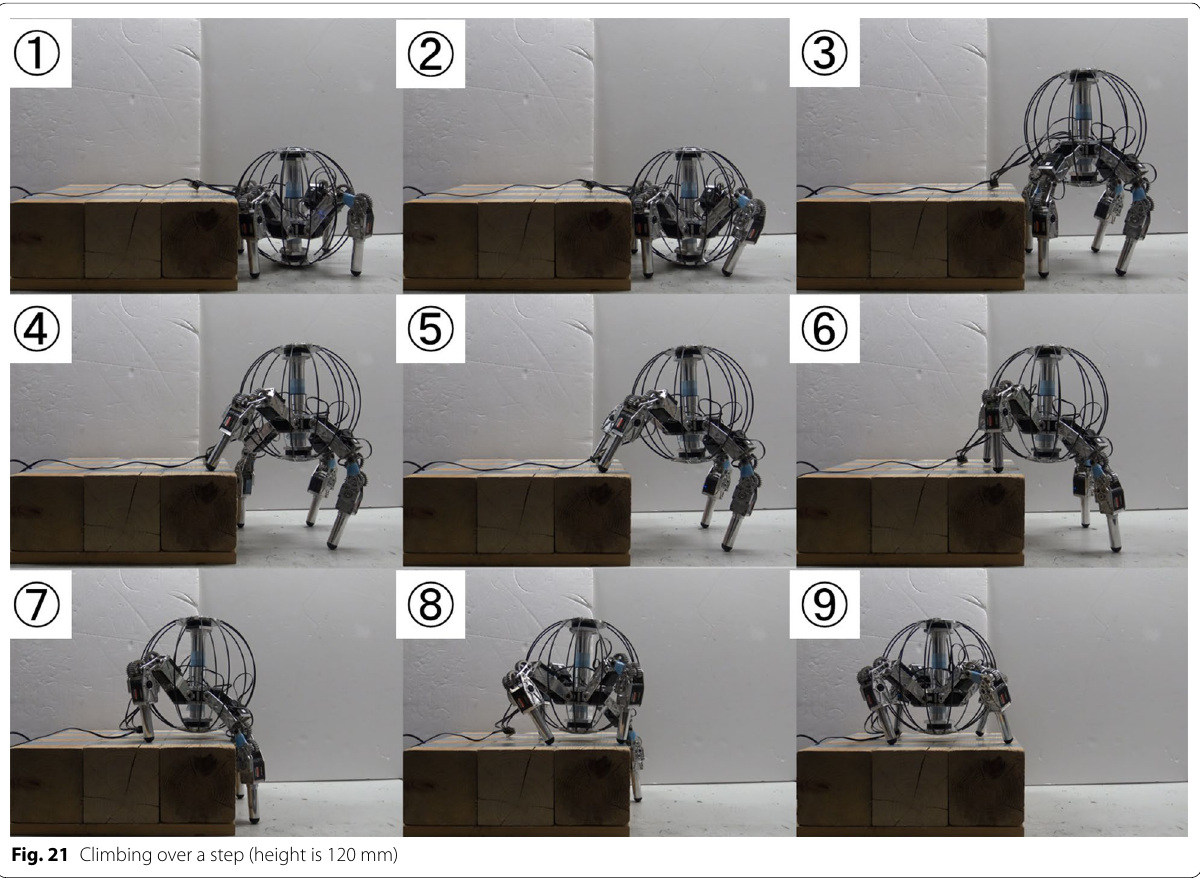
Fig. 21 Climbing over a step (height is 120 mm)